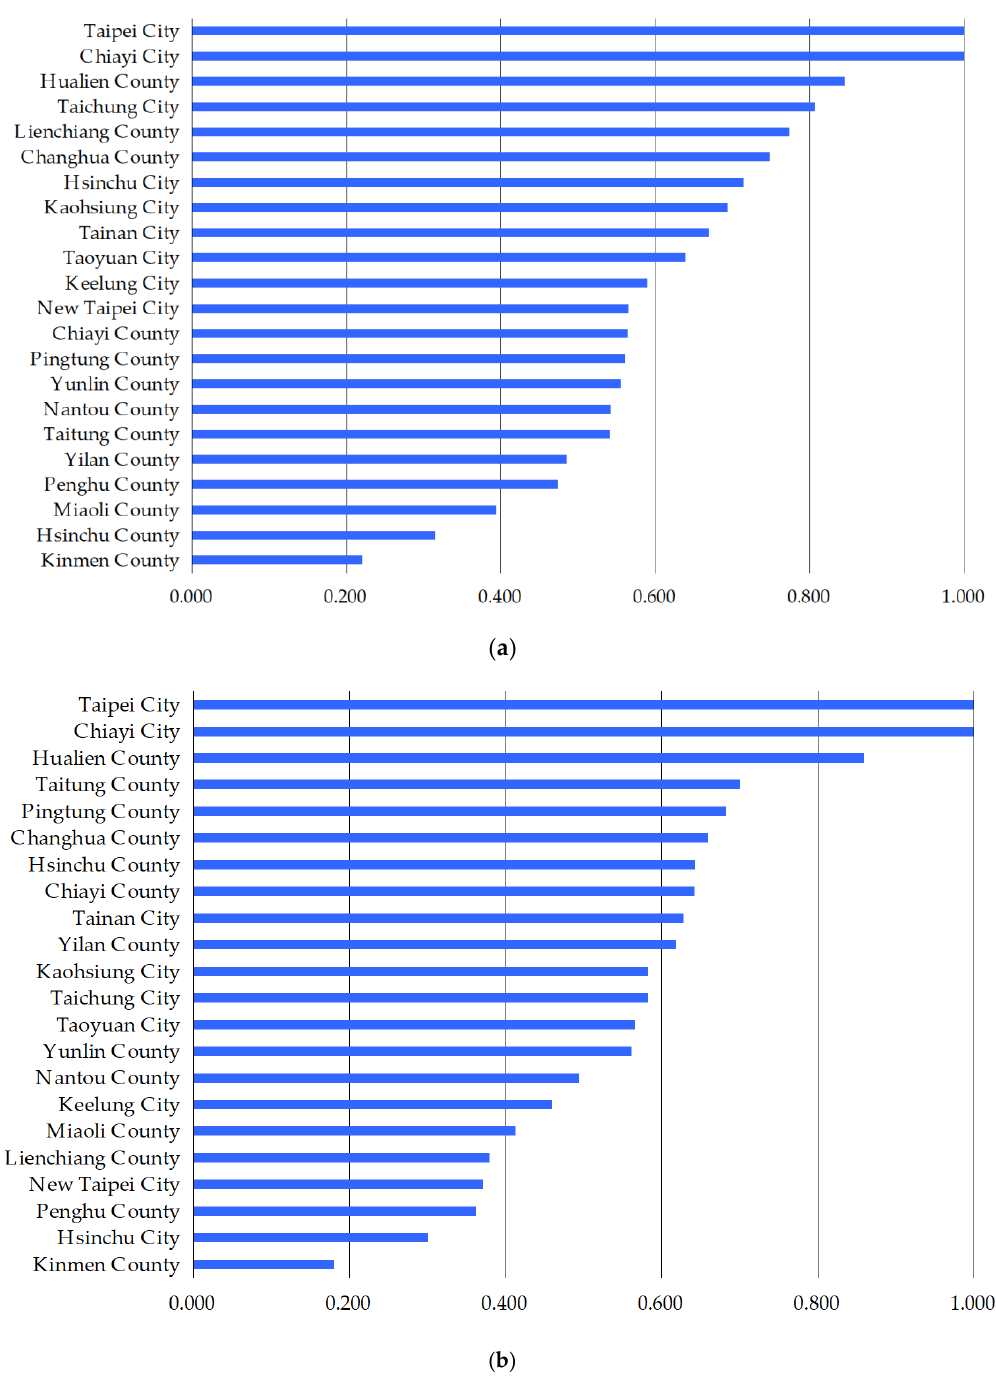
Figure 2. ( a ) Average carrying efficiency of physicians for administrative regions in Taiwan; ( b ) Average carrying efficiency of nurses for administrative regions in Taiwan.